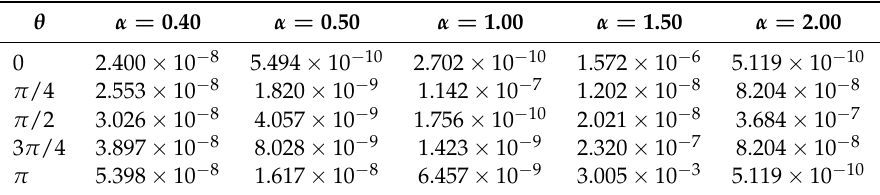
Table 2. The absolute relative error in the computation of Ein α , β ( z ) from Theorem 1 for different α and θ when z = 20 e i θ and β =